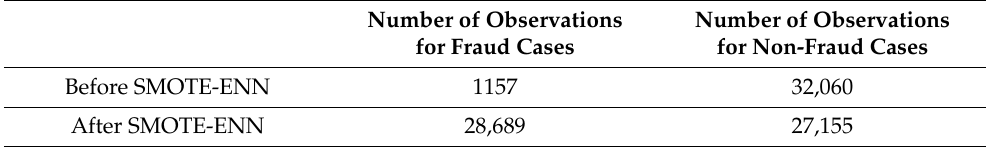
Table 1. The number of observations for each class (fraud and non-fraud) before and after